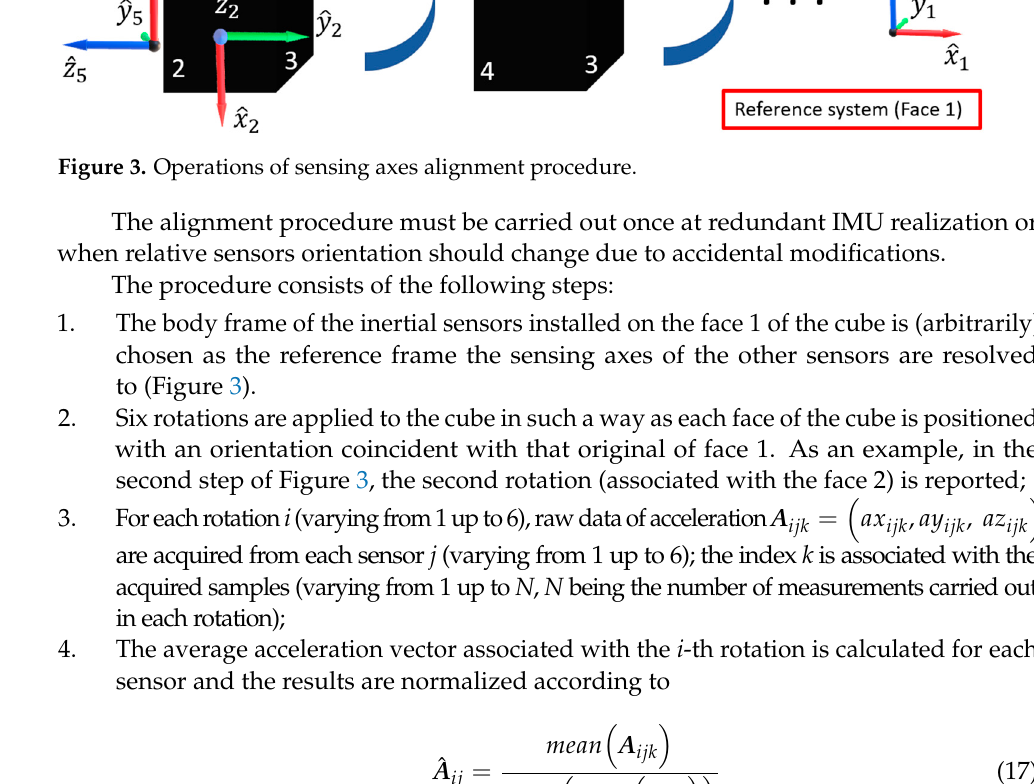
Figure 2. Flow chart of the measurement procedure.